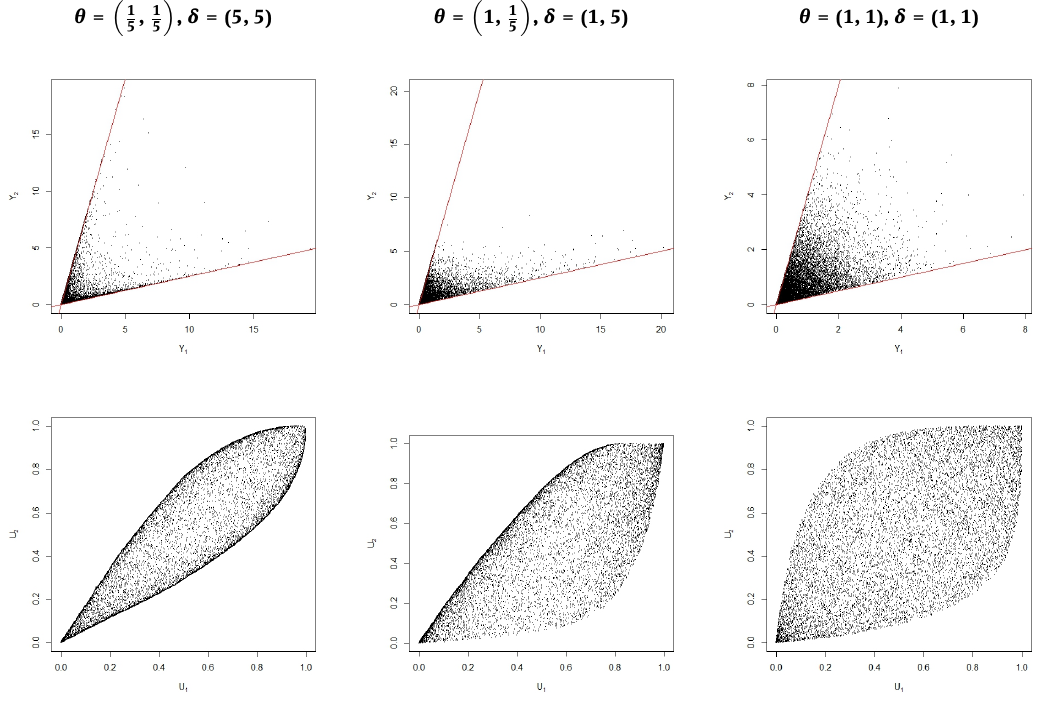
Fig. 2. 10,000 realizations of the multivariate distribution (first row) and the implicit copula (second row) defined by equa- tion